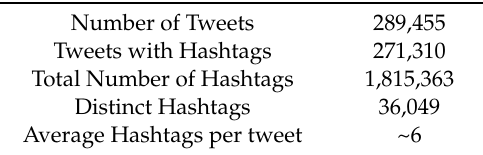
Table 2. Data collection summary statistics.